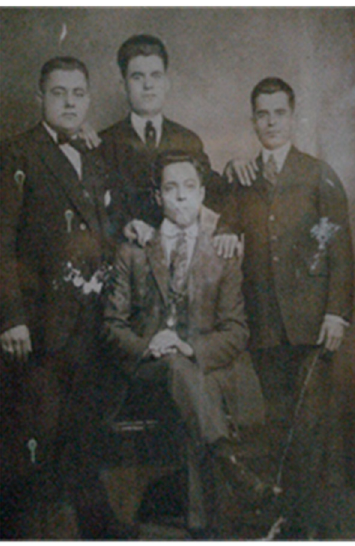
Figure 5. Giorgos, Antonis, friends and kin handshake (author’s collection).